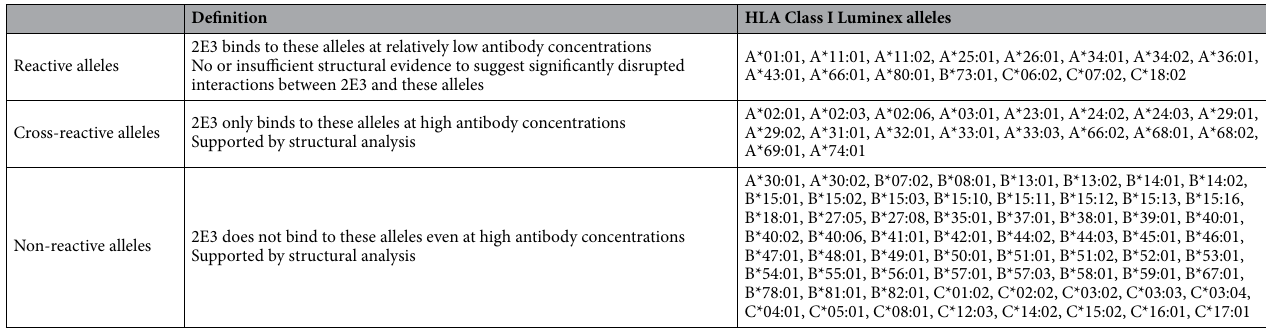
Table 1. List of HLA Class I Luminex alleles based on binding activity of antibody